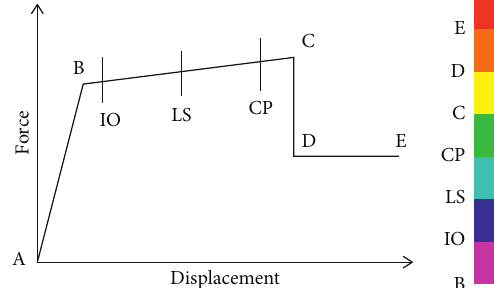
Figure 14: Force-deformation behavior of